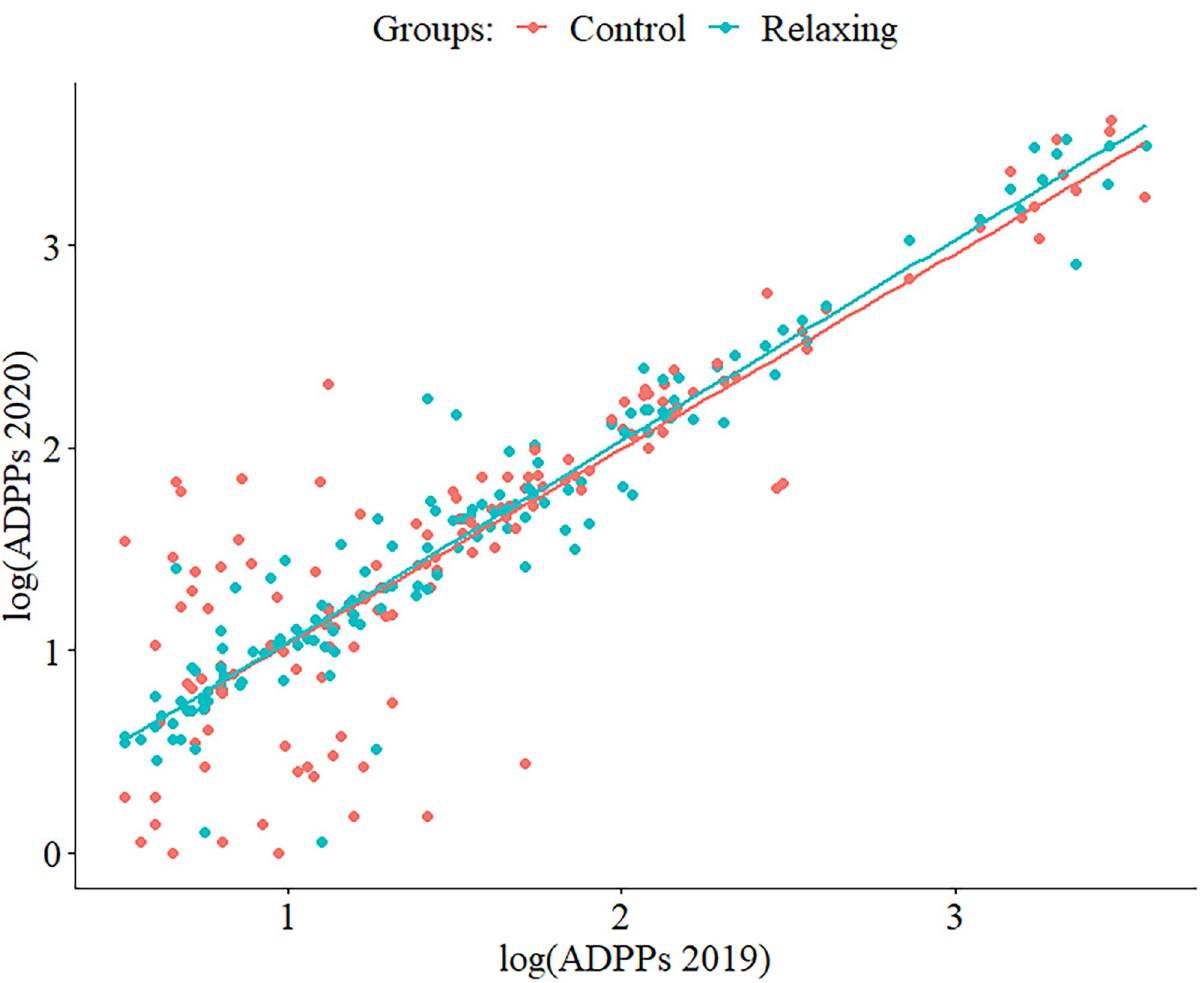
Fig 4. Scatterplot of the relation between ADPPs in 2019 and ADPPs in 2020 by groups. S cales have been log-transformed for clearer data presentation.